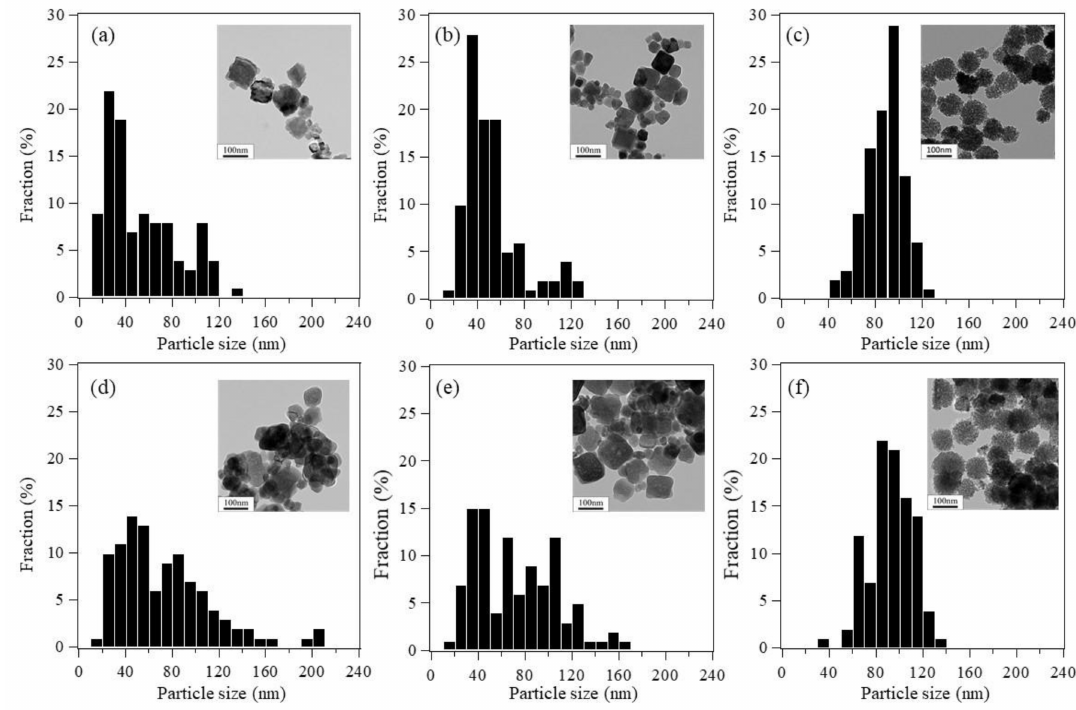
Figure 9. Particle size distributions and TEM images of the ( a , d ) randomly shaped; ( b , e ) cube-like; and ( c , f ) raspberry-shaped Co 3 O 4 nanoparticles before ( a , b , c ) and after ( d , e , f ) the CO conversion